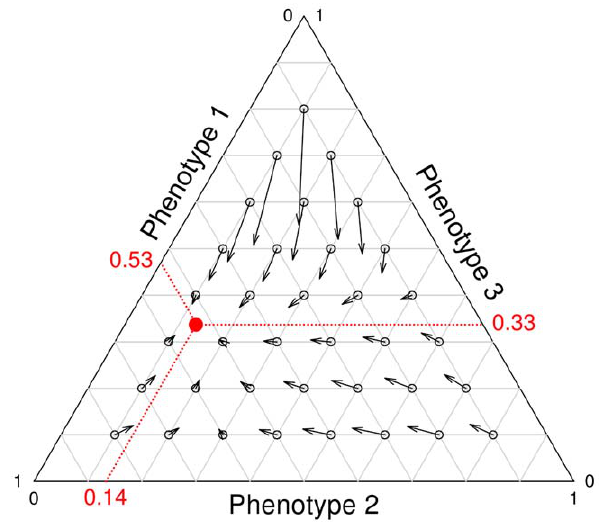
Figure 7. Selection pressures that act on the three most abundant phenotypes. The direction of an arrow shows how the phenotype frequencies change over time. The length of an arrow indicates the speed of this change and hence the strength of selection. The red dot shows to the phenotype frequencies at equilibrium (i.e. the population state in which all phenotypes have exactly the same fitness). The frequency changes are determined from the onset of the current nutritional cycle to that of the next nutritional cycle. The calculations therefore include both cellular-level and colony-level selection. For the parameter settings see figure